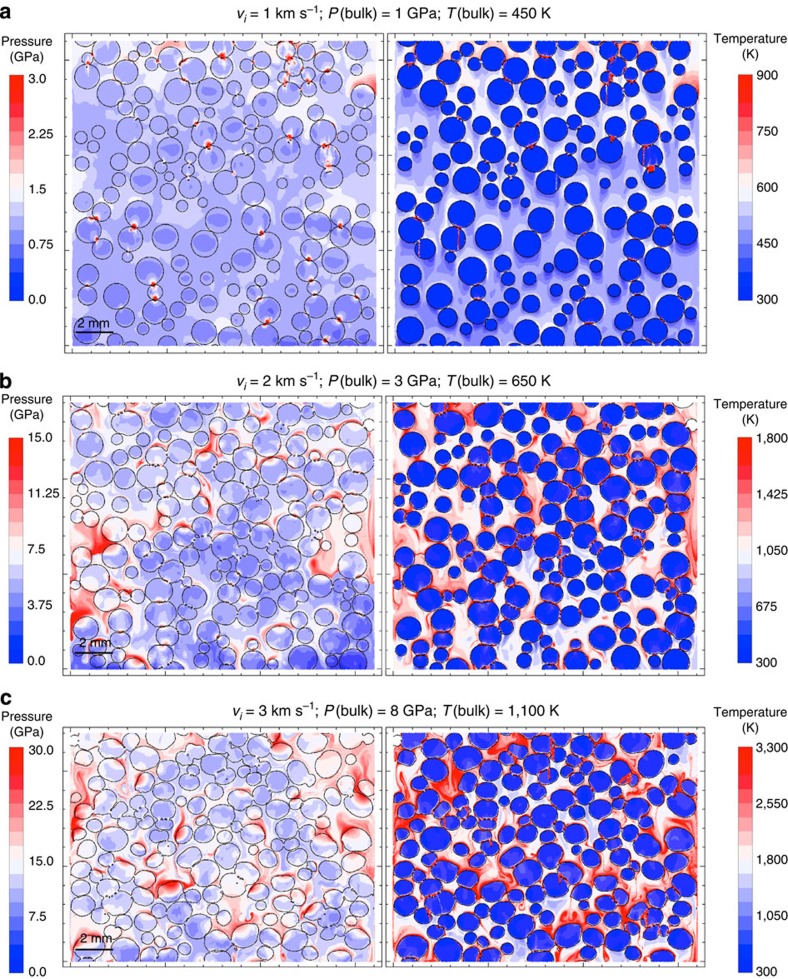
Variation in peak-shock pressure and peak temperature in mesoscale simulations.In the examples shown, matrix is composed of forsterite, initial matrix volume fraction is 70%, initial matrix porosity is 70% and starting temperature is 300 K. (a) 1 km s−1 impact results in bulk shock pressure ~1 GPa; (b) 2 km s−1 impact results in P(bulk) ~3 GPa; (c) 3 km s−1 impact results in P(bulk) ~7 GPa. The images illustrate the variation in P(peak) and T(peak) recorded by a representative portion of the sample after passage of the shock wave. Note the change in pressure and temperature scale between frames. The extreme variability in matrix PT over short lengthscales is apparent, indicated by swirling contours in matrix. Our simulations reproduce a variety of chondrule/matrix textures observed in the chondrite record (elongate or oriented chondrules; matrix ‘flowing’ between chondrules; indented chondrules). Chondrule indentation textures become apparent at 2 km s−1 (1.5 km s−1 at lower matrix vol% (for example, OCs)); internal chondrule P(peak) ~5 GPa.